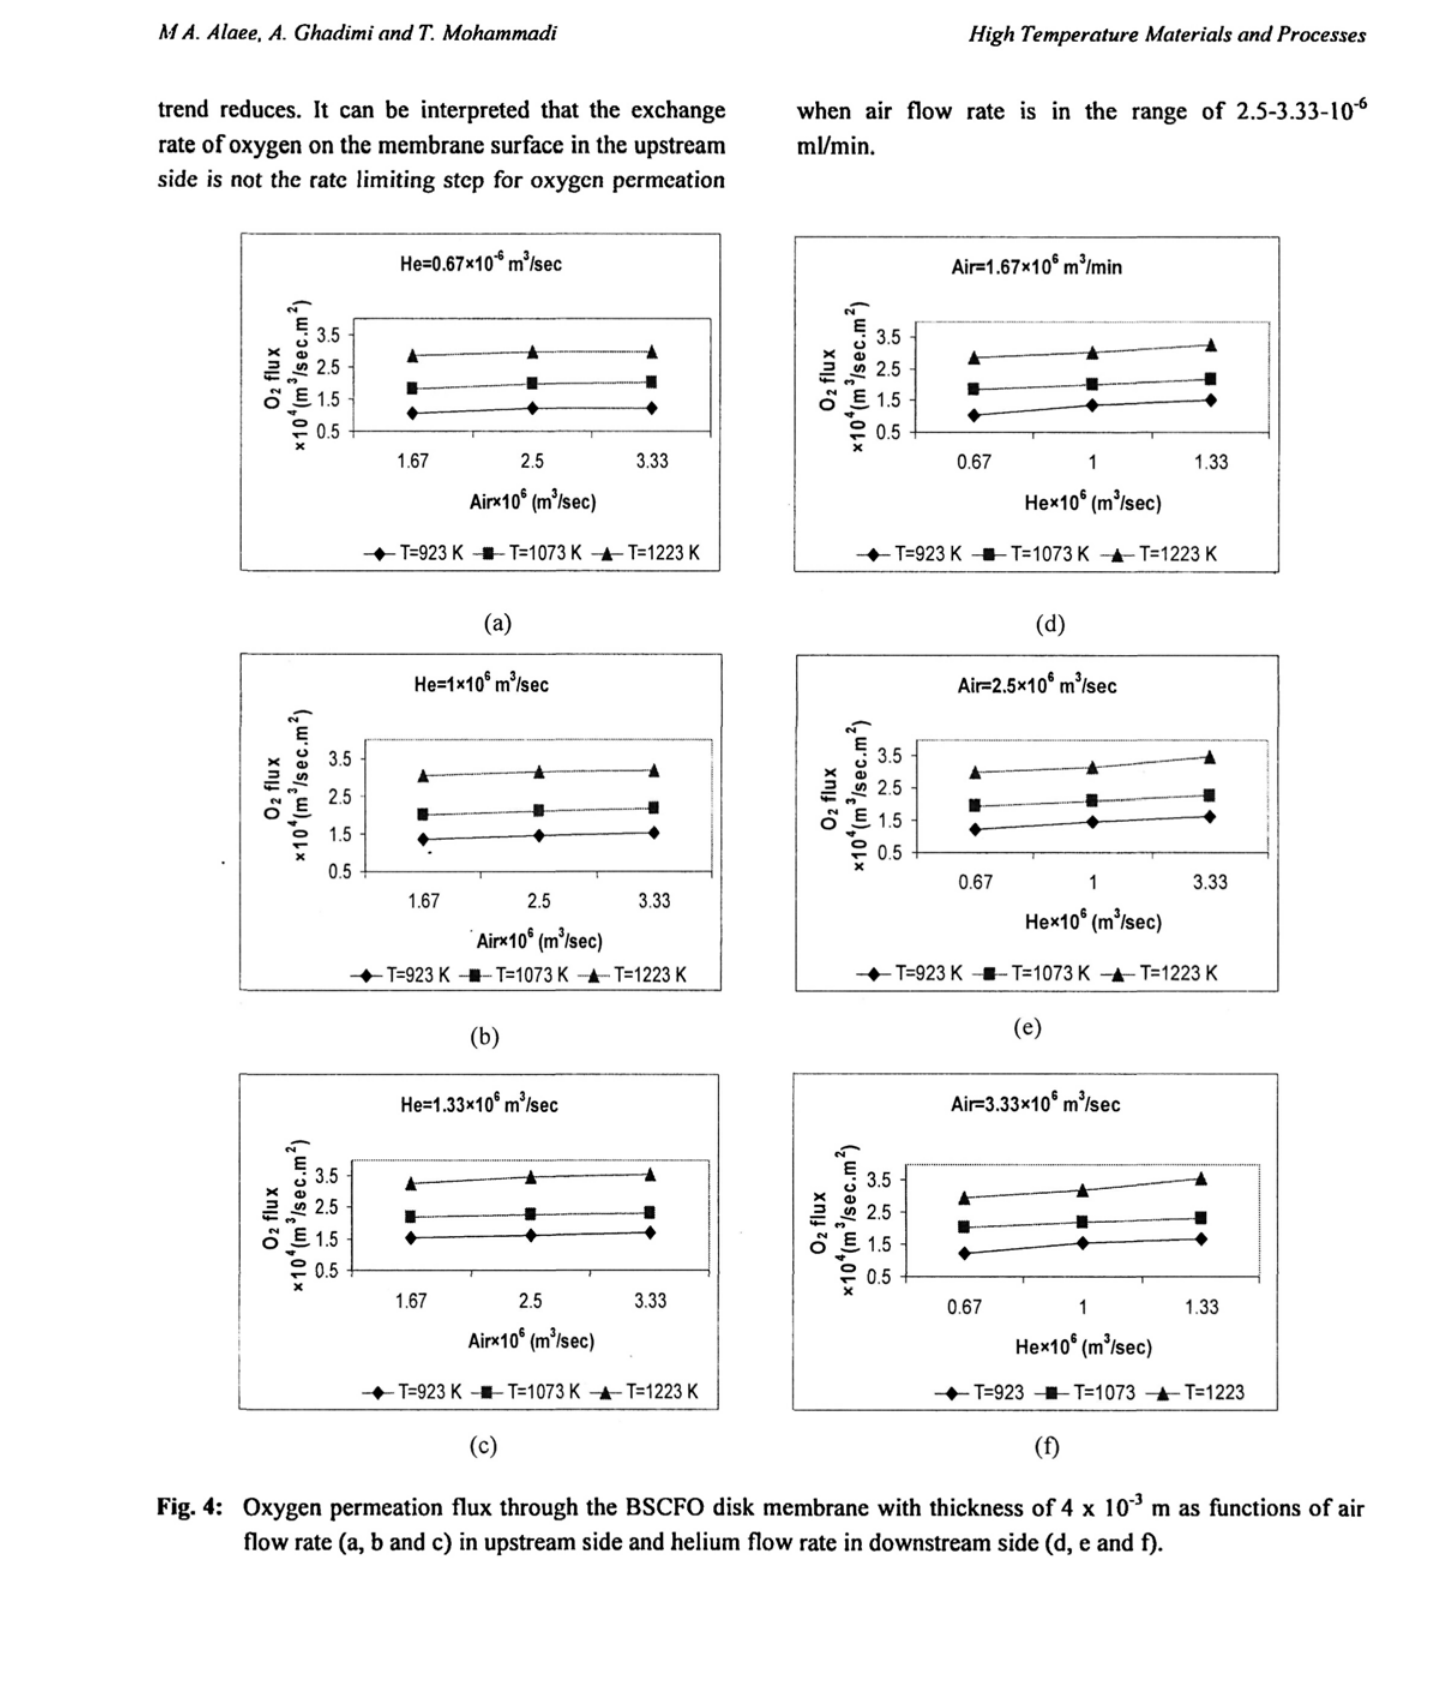
Fig. 4: Oxygen permeation flux through the BSCFO disk membrane with thickness of 4 χ ΙΟ" 3 m as functions of air flow rate (a, b and c) in upstream side and helium flow rate in downstream side (d, e and